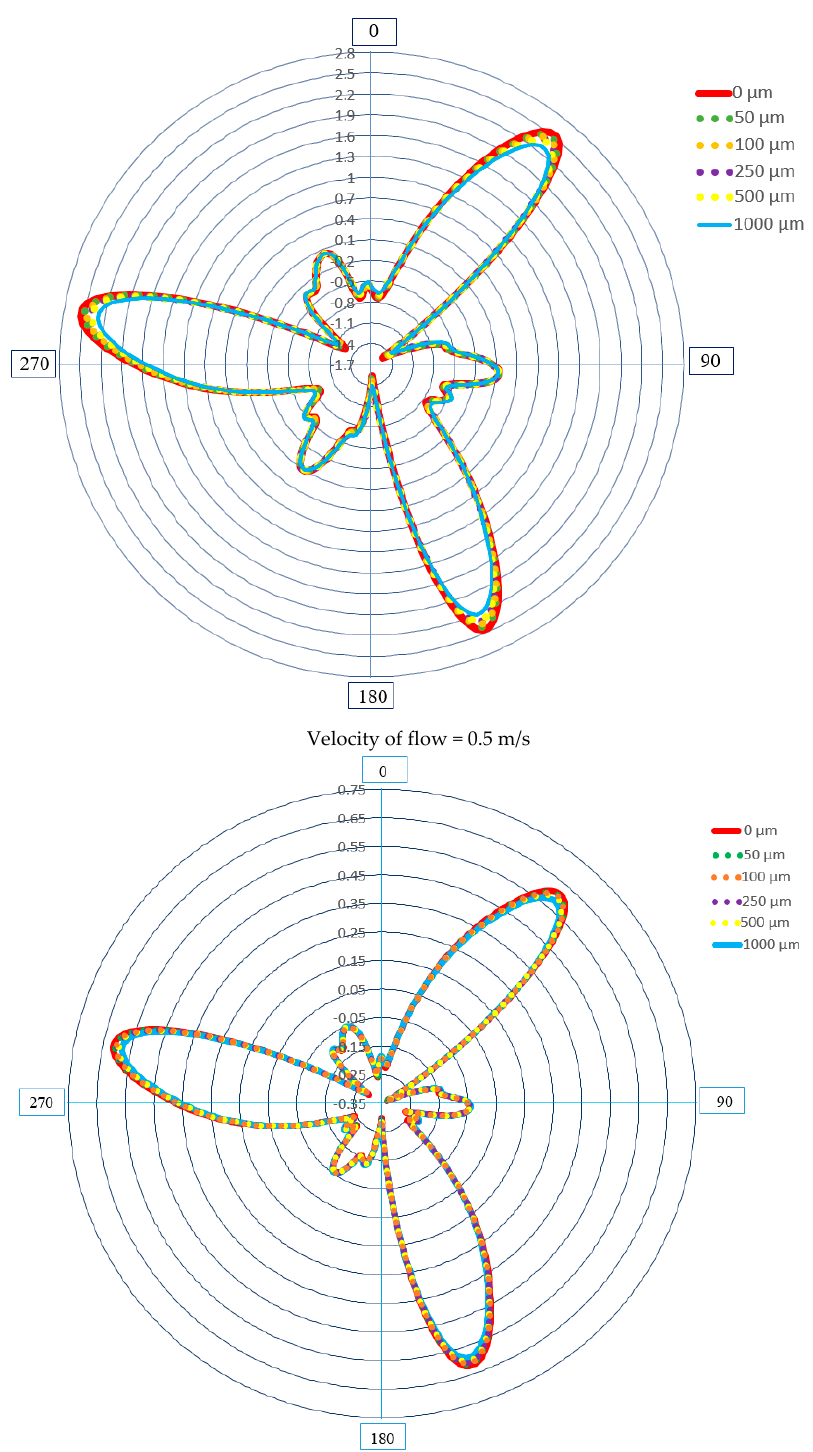
Figure 13. Torque ( T ) vs. azimuthal angle for six different roughness heights at ζ = 1.5.